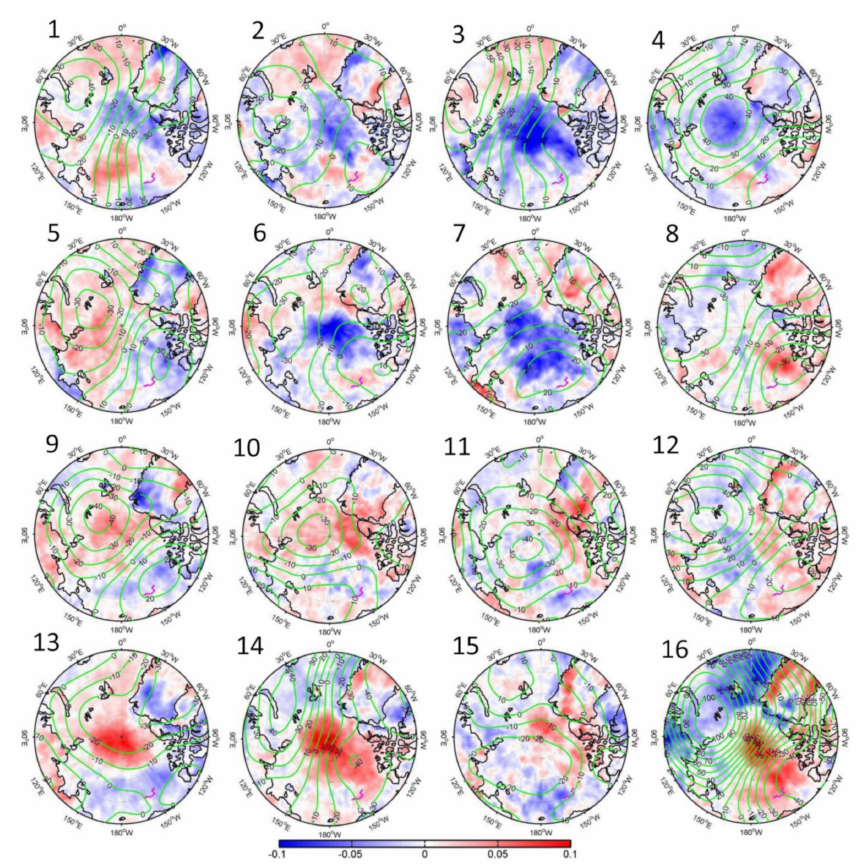
Figure 9. The 500-hPa potential height (gpm) (contour) and total cloud cover (shading) composite for each SOM pattern. The pink lines denote the track of the SHEBA campaign during January 1998.